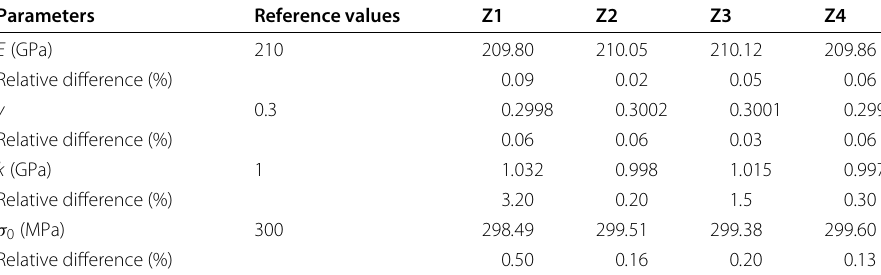
Table 1 Identified parameters: specimen 2